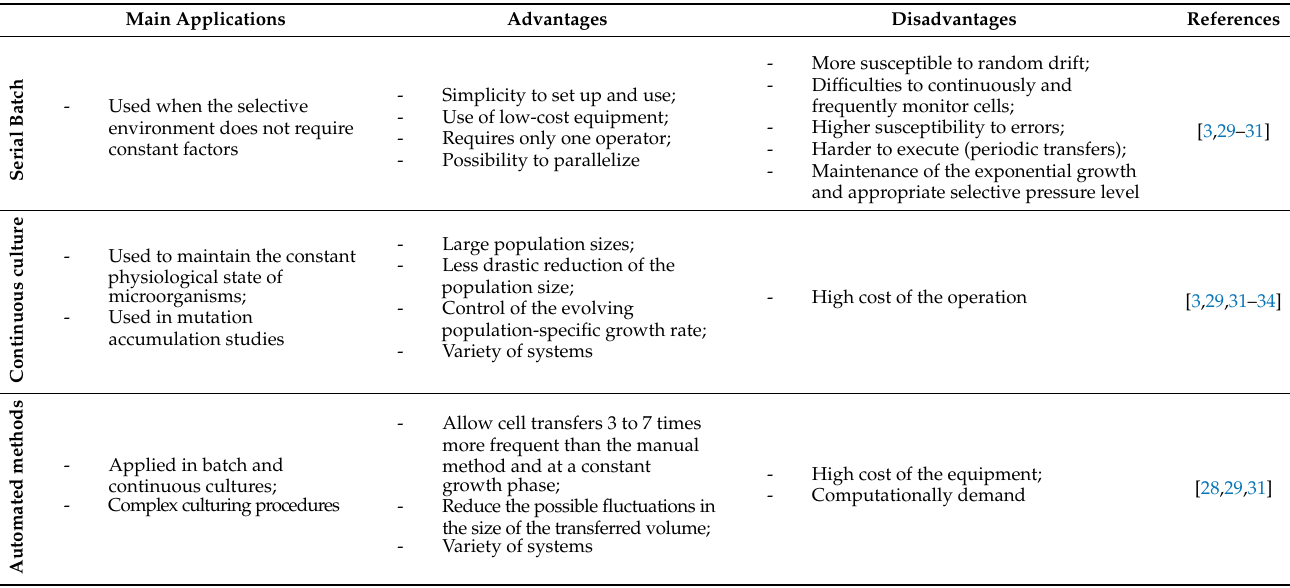
Figure 1. Schematic overview of the experimental serial batch culture approach. ( A ) Microorganisms are cultured in flasks with liquid media, chosen to mimic a desired selective condition, for an extended period of time, and aliquots of the cells’ population are sequentially transferred to fresh media. Cells will undergo recombination and mutations, over time, generating evolved strains. ( B ) Colony transfer is a similar process to liquid transfer but is performed in solid medium plates. ( C ) Continuous cultures are usually carried out in chemostat tanks, in which fresh medium is introduced at a stable flow rate and effluent fluid emerges at the same rate, maintaining constant environmental culture conditions. Table 1. Main applications, advantages, and disadvantages associated with different ALE approaches: Serial batch, continuous culture, and automated